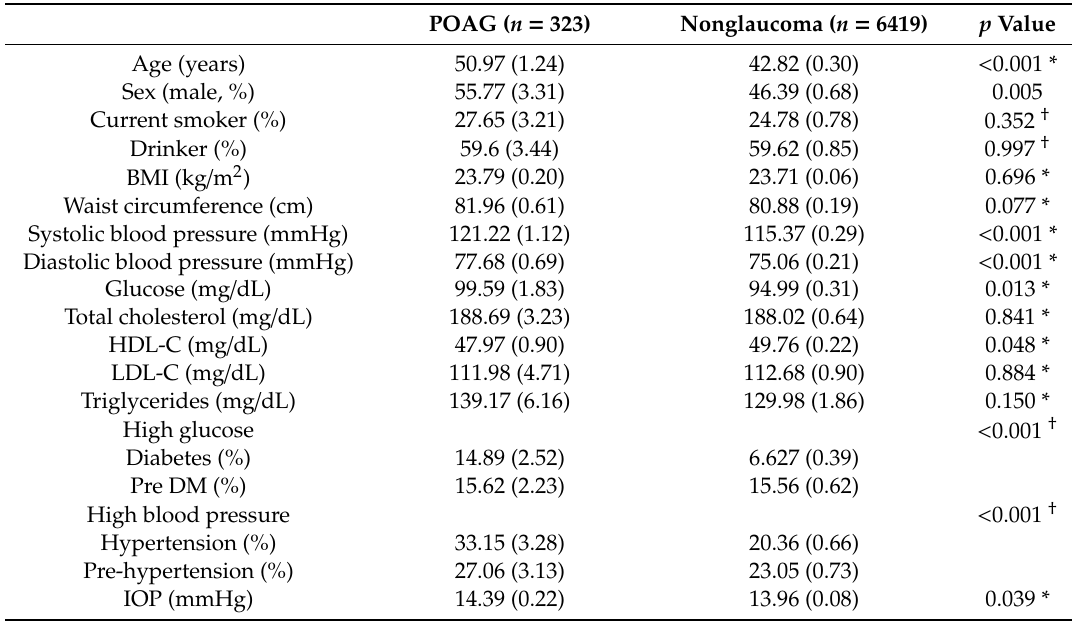
Table 1. Demographics of enrolled subjects. All subjects completed the health questionnaire and underwent eye